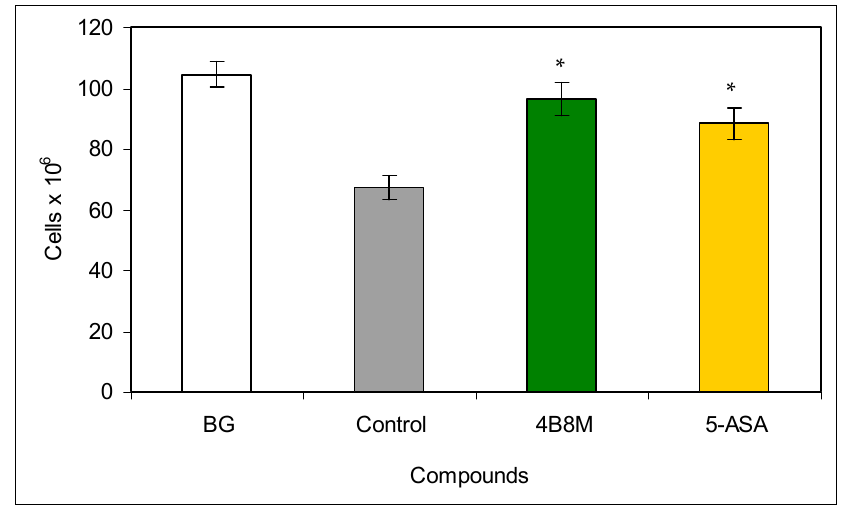
Figure 7. E ff ects of the compounds on the number of thymocytes in mice with dextran sulfate-induced colitis: the mice drank a 4% solution of dextran sulfate in acidified water for 6 days (days 0–5). The peptide 4B8M and reference drug Pentasa ® (5-ASA) were administered to mice intragastrically by a stomach tube daily on days 1–5. On day 12 of the experiment, the thymuses were isolated and the cell numbers were counted. The results are given in 10 6 cells per thymus (mean values ± SE). * Control vs. compounds p < 0.05 (ANOVA).